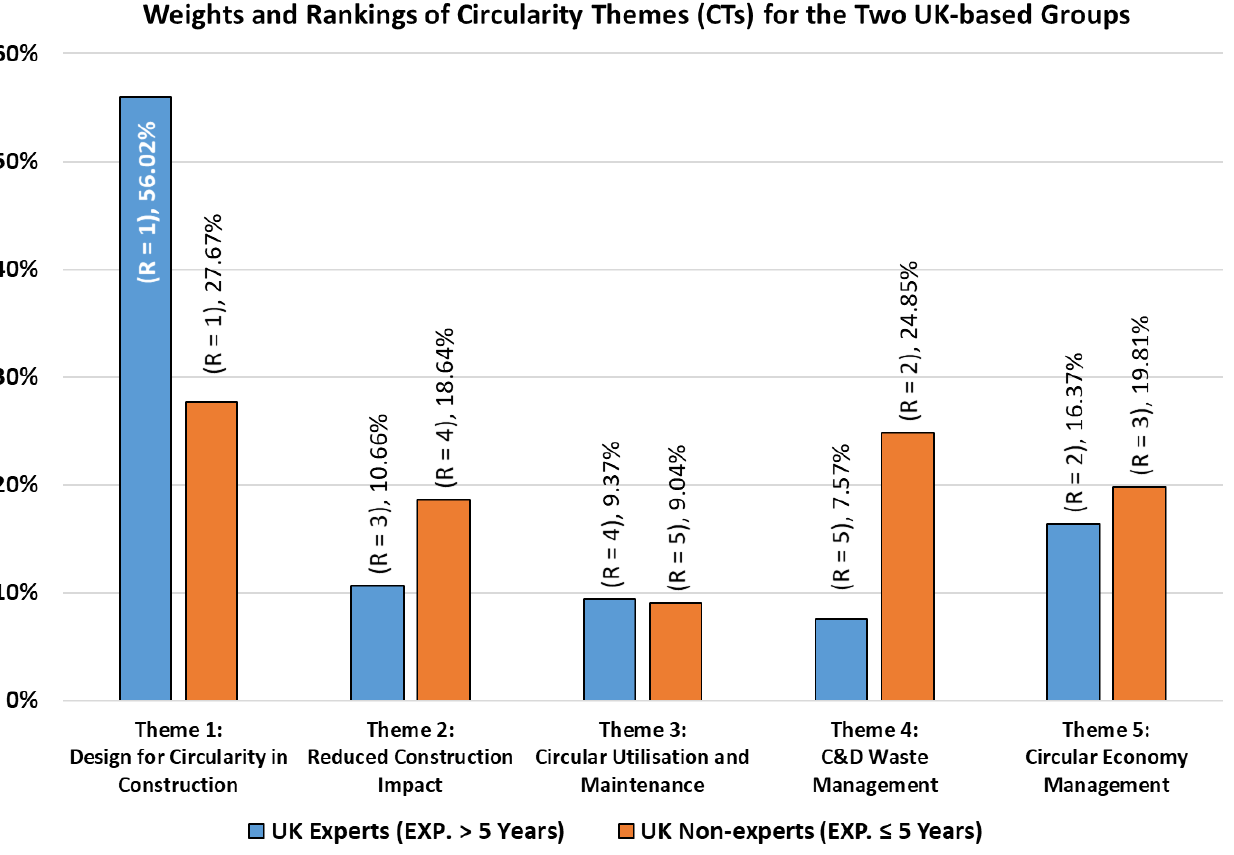
Figure 6. Weights/rankings of circularity themes (CTs) for the UK-based groups.